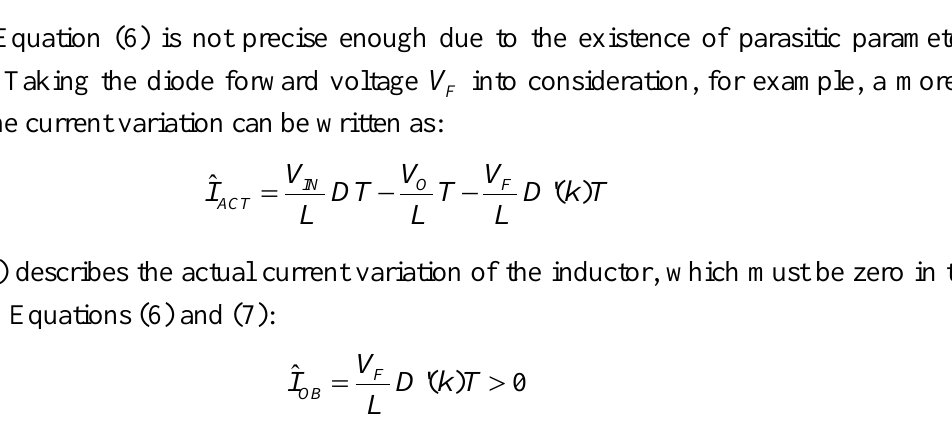
Figure 3. The observed current with different